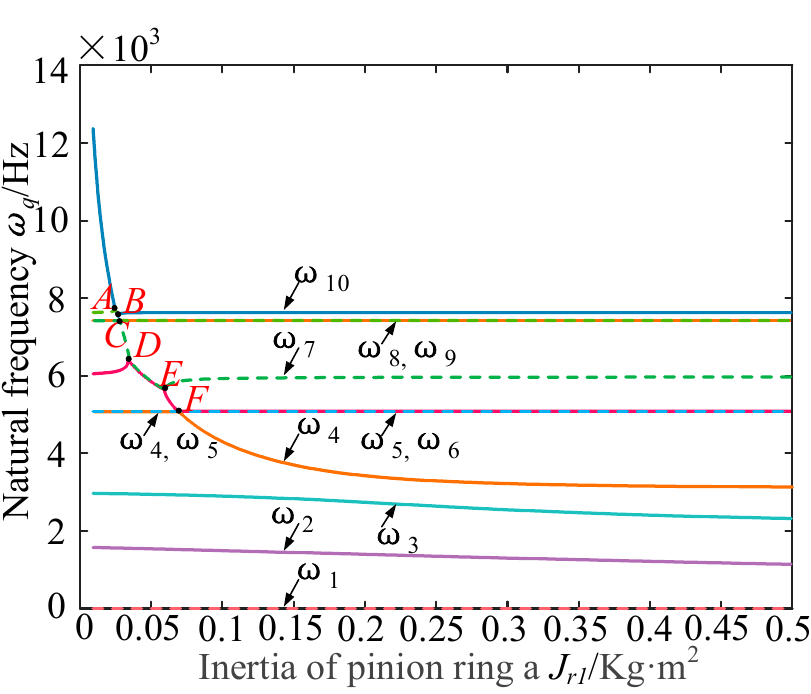
Figure 12. The trajectory of the natural frequency with J r 1 .